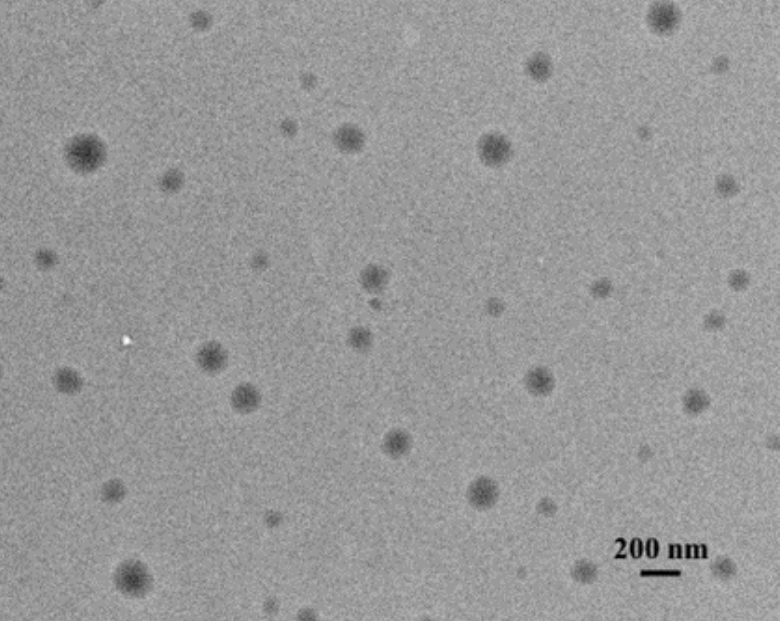
Figure 2. Micrograph obtained on a transmission electron microscope for PC/Tw20/C 14 PB at molar ratio of components 1/0.2/0.025.